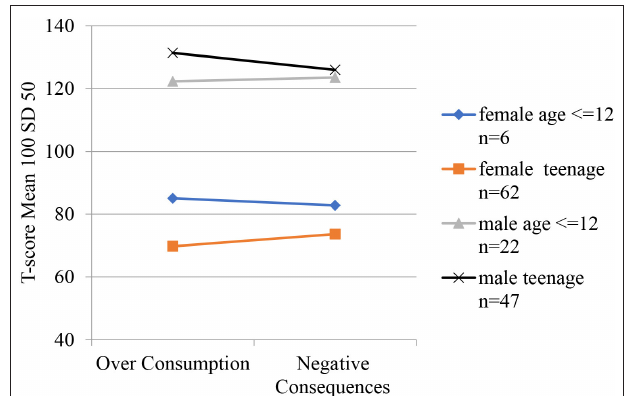
FIGURE 5 | Over consumption and negative consequences mean profiles for gender by age groups. Scale is aligned factor T-scores. Mean 100 and SD 50 for the CAP sample. For data see electroninc Supplementary Table 6 .